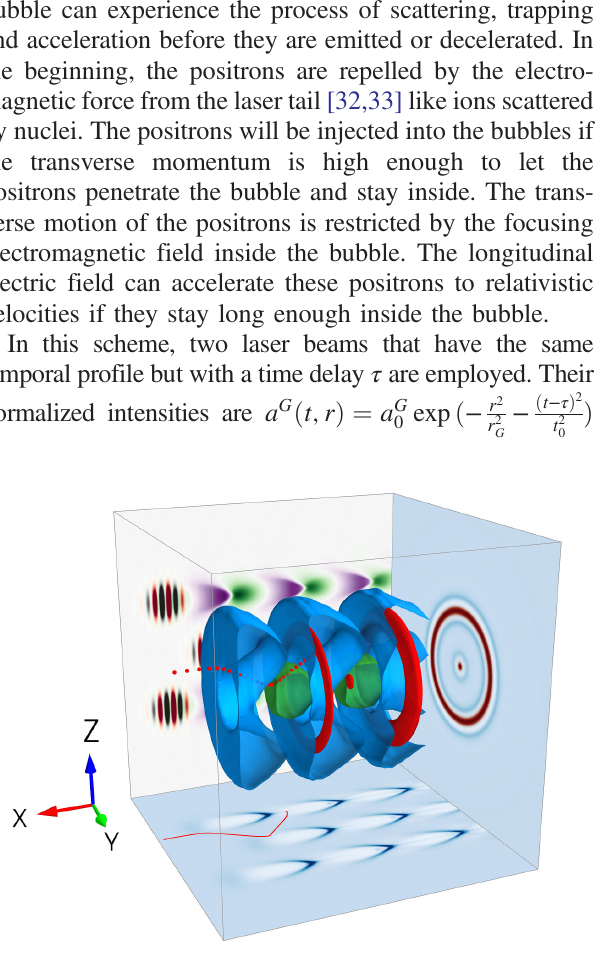
FIG. 1. The concept of the positron ballistic injection scheme. The blue and green colors are contour surfaces of electron densities of donut and center bubbles, respectively. The red color represents injected positrons. The x – y and x – z planes are transverse slices of the density distribution and the longitudinal electric field E . The red curve in the x – y plane is the trajectory x of an injected positron (corresponding to the projection of red balls in the 3D model). The leading oscillating colors (amber and grey) denote the laser beams in the x – z plane. The y – z plane is the projection of electron density (blue) and injected positron density